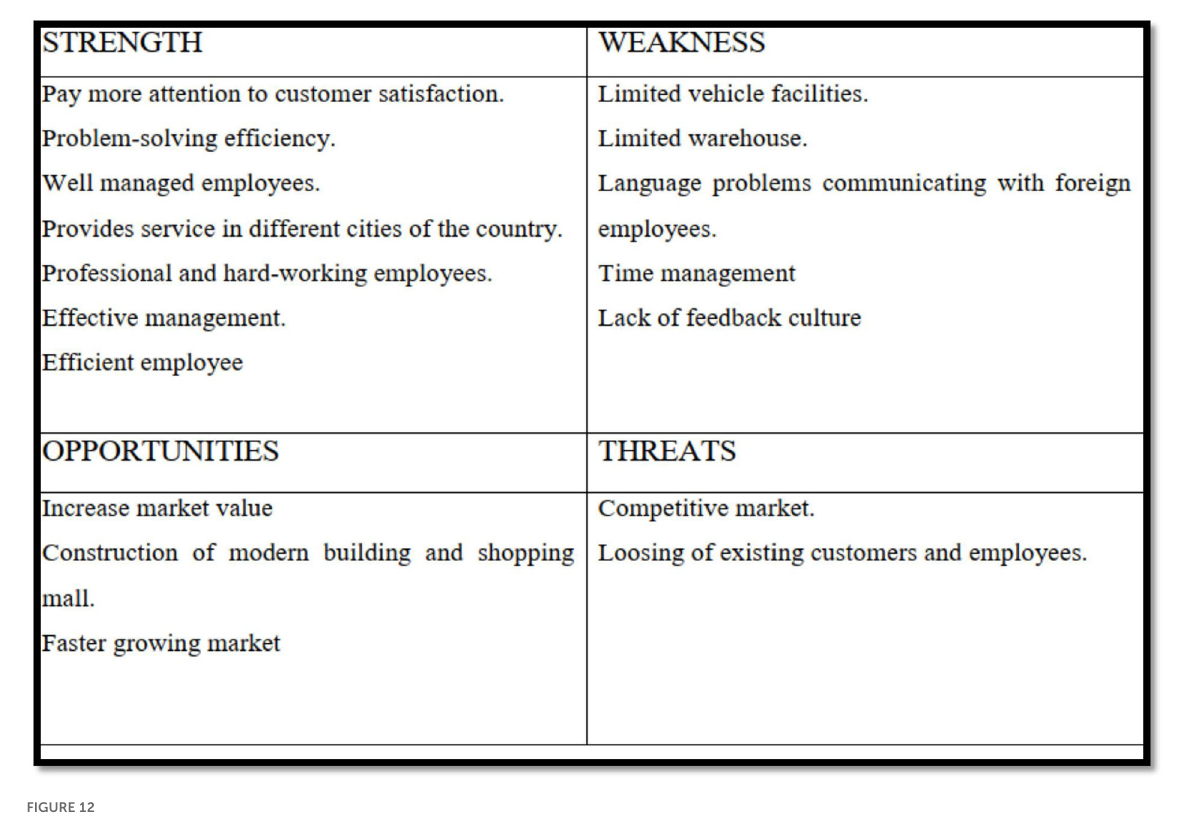
FIGURE12 SWOT analysis of